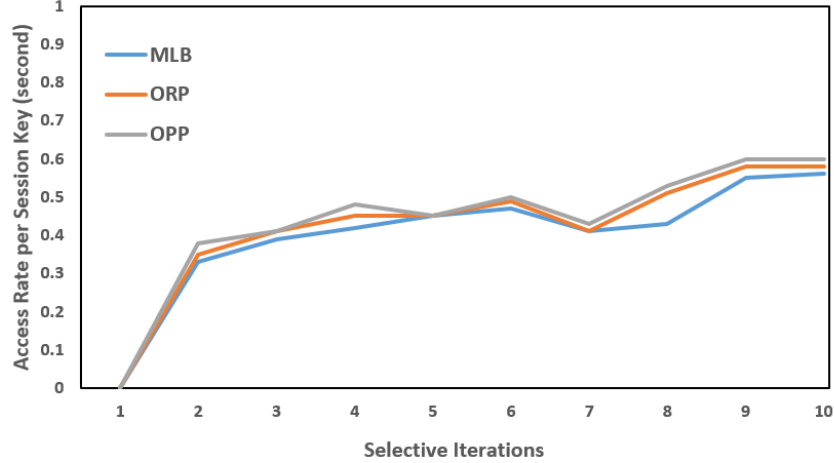
Figure 7. AV access rates per session key: session key = 2 s; time period = 20 min.